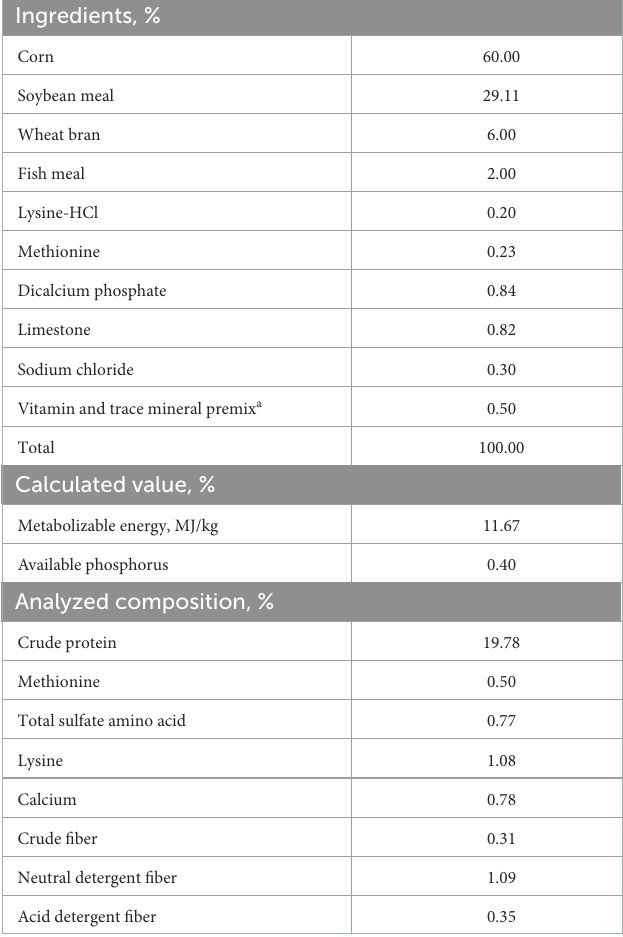
TABLE 1 Composition and nutrient levels of the experimental basal diet (%, as-fed